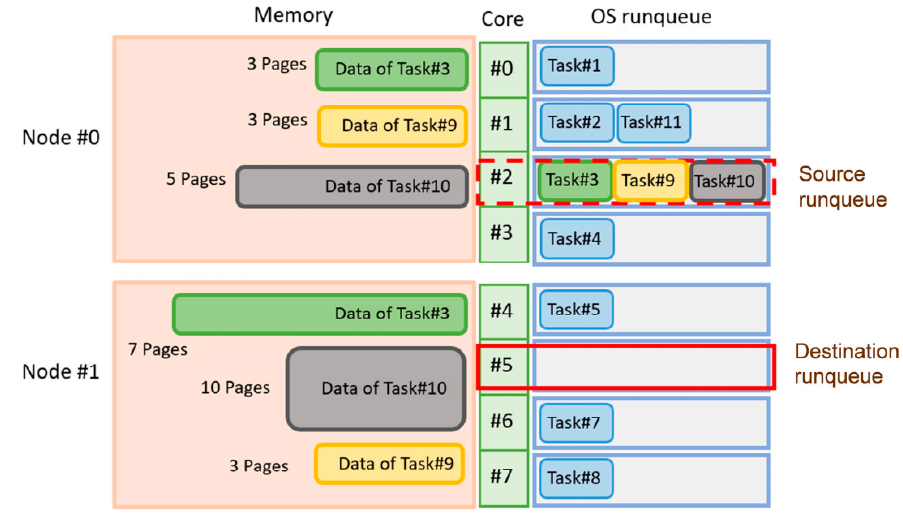
Figure 2. Migrating different tasks incurs a different degree of remote memory access after migration.